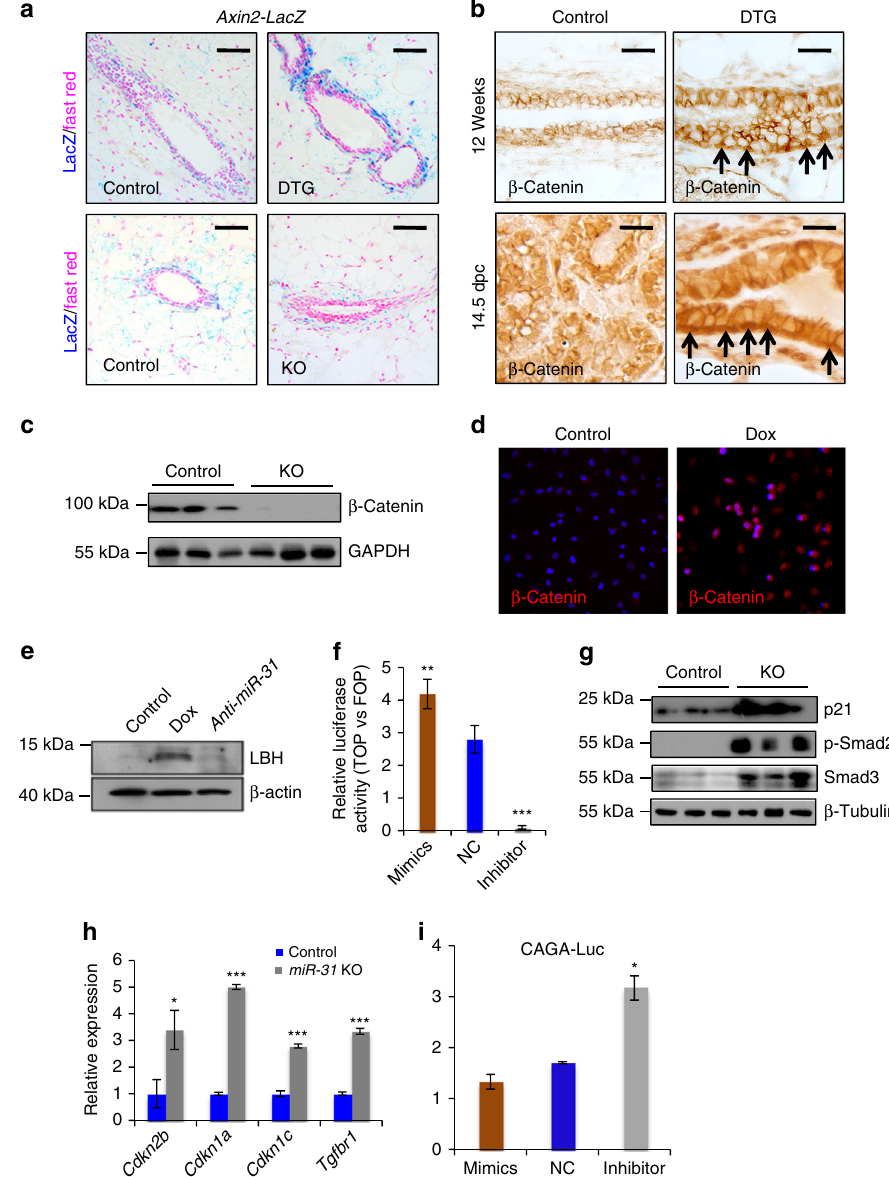
Fig. 7 MiR-31 activates Wnt and represses TGF β signaling pathways. a Wnt signals were evaluated by Axin2-LacZ reporter activity in mammary ducts from Control ( n = 3) and DTG ( n = 3) mice, as well as Control ( n = 3) and miR-31 KO ( n = 3) mice. Blue, LacZ signals. Scale bar, 100 μ m. b Immunohistochemistry for β -Catenin in Control ( n = 3) and DTG ( n = 3) mammary glands at 12 weeks of age and 14.5 d.p.c. Arrows, nuclear localized β -Catenin. Scale bar, 25 μ m. c Western blotting for β -Catenin in Control ( n = 3) and miR-31 KO ( n = 3) mice. GAPDH was used as a loading control. d Immuno fl uorescence for β -Catenin in HC11 mouse mammary epithelial cells in the presence of Dox ( miR-31 overexpression). Control, without Dox. Red, β - Catenin; Blue, DAPI. n = 3 technical replicates. e Western blotting for Wnt target LBH in miR-31 overexpressing (Dox) or miR-31 inhibited ( anti-miR-31 ) HC11 mammary epithelial cells. The Control HC11 cells were treated with Scramble RNA. n = 3 technical replicates. f TOP/FOP fl ash luciferase assays demonstrate that Dox induced miR-31 overexpression activates Wnt reporter gene expression and that miR-31 inhibitor ( anti-miR-31 ) markedly represses Wnt reporter gene expression. Scramble RNA was used as negative control (NC). n = 3 technical replicates. g Western blotting for Smad3, p-Smad2/3 and p21 in mammary epithelial cells of Control ( n = 3) and miR-31 KO ( n = 3) mice at 10 weeks of age. h qRT-PCR analysis for TGF β components and downstream target genes, Cdkn2b (encoding p15), Cdkn1a (encoding p21), Cdkn1c (encoding p57) and Tgfbr1 in mammary epithelial cells of Control ( n = 3) and miR-31 KO ( n = 3) mice at 10 weeks of age. i HC11 mammary epithelial cells were transfected with CAGA luciferase reporter vector, combined